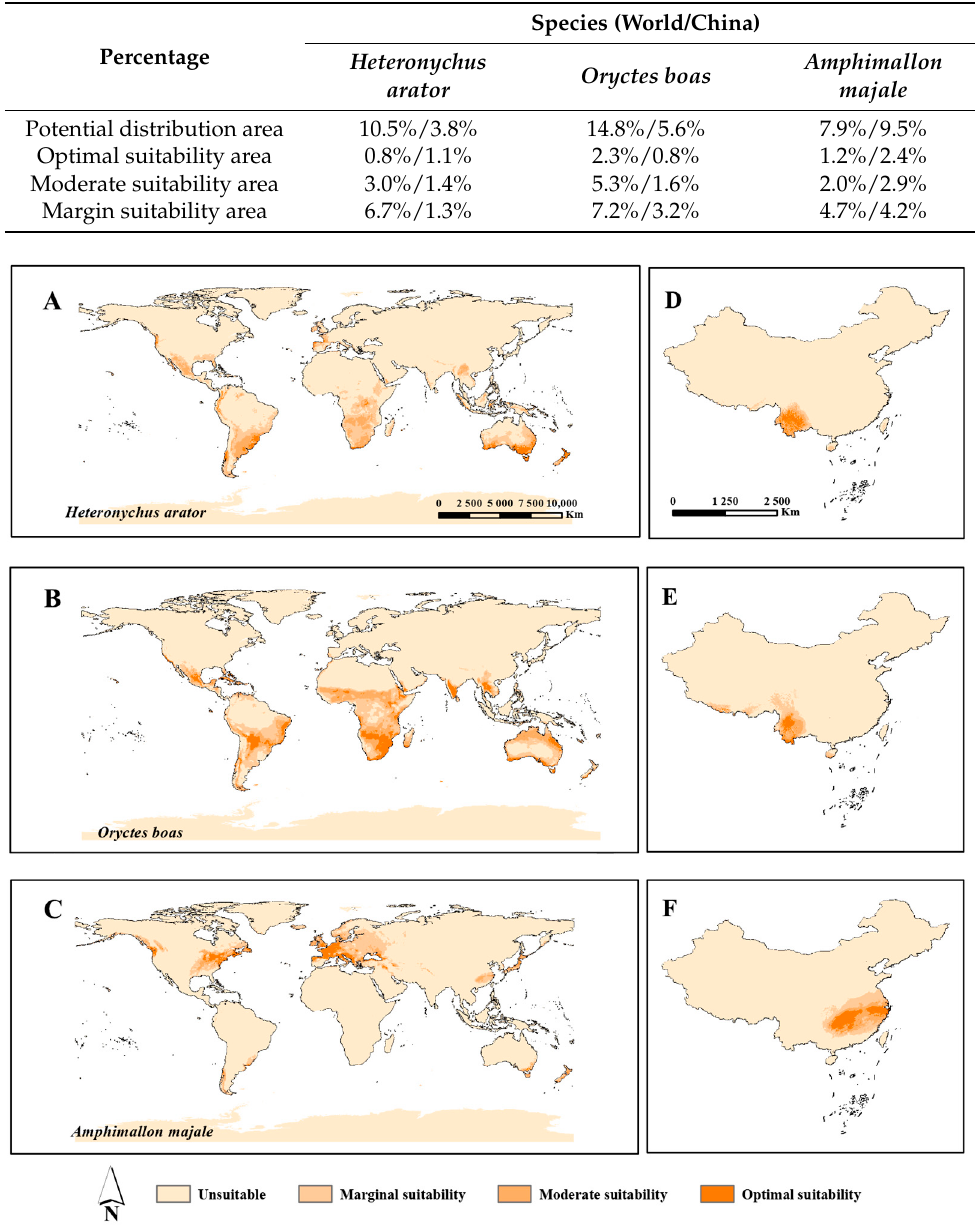
Figure 3. Potential distribution of Heteronychus arator , Oryctes boas and Amphimallon majale in the world ( A – C ) and in China ( D – F ). ( A , D ): For Heteronychus arator , the range of the suitablility (occur-